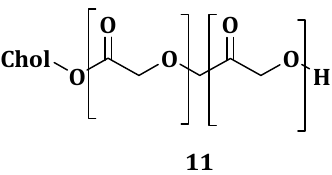
Figure 4. Chemical structure of PLGA-C ( 11 ).